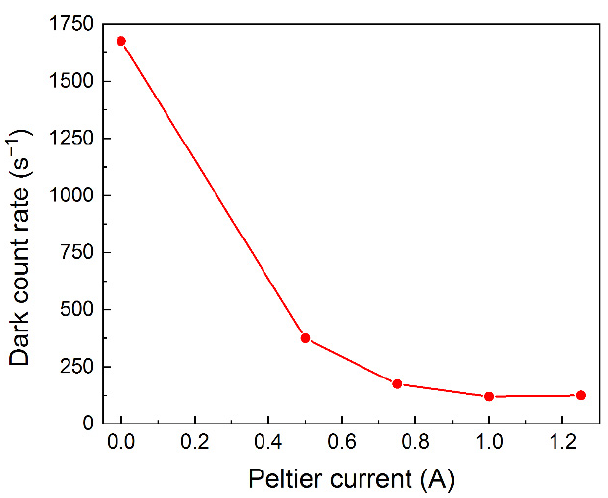
Figure 13. Dependence of dark count rate of the developed cooled HPD on the applied Peltier current [32]. Application of 1.2 A Peltier current cooled the HPD to about 283 K at an ambient temperature of 298 K.